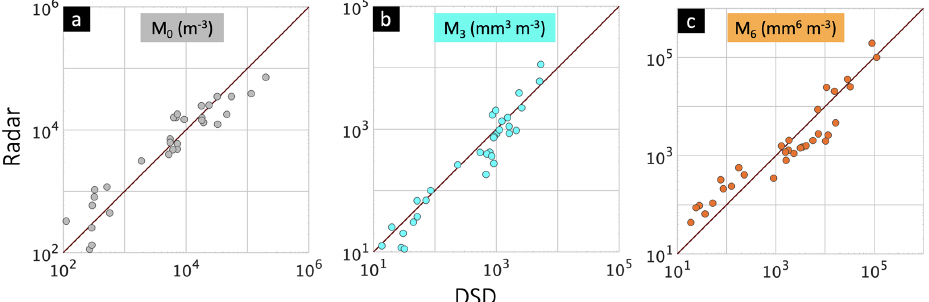
Figure 10. Scatter plot of radar-derived moments versus “true” moments from the complete DSD data on log 10 scales. (a) M 0 , (b) M 3 , and (c) M 6 . Table 2. Statistics of the RB (median and IQR range). The correlations are between radar-retrieved moments and directly computed moments from the complete DSD measured by disdrometers. Median of RB IQR ([25th, Spearman’s Pearson’s Moment distribution (%) 75th] percentiles) rank correlation correlation M 0 − 13 . 1 [ − 34 . 5, 81.9] 0.907 0.900 M 1 − 17 . 4 M